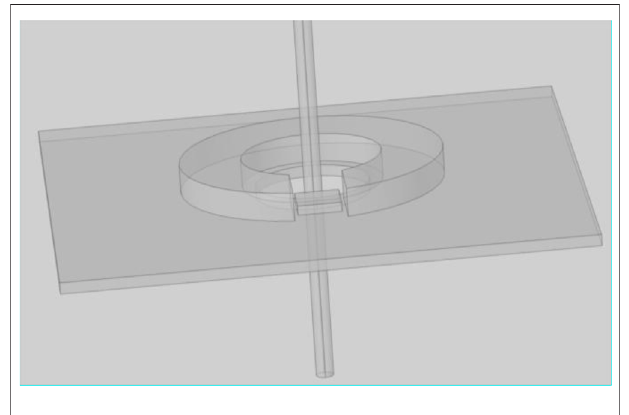
FIGURE 2 | Simulation model built.